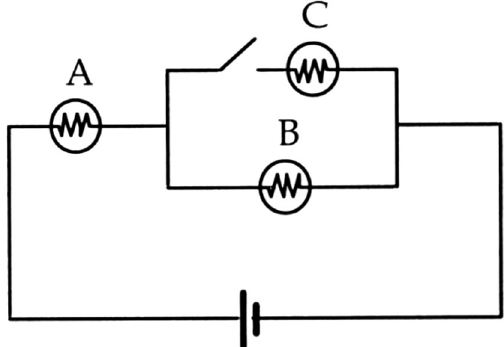
FIG. 2. A typical, qualitative circuit question (from Engelhardt and Beichner